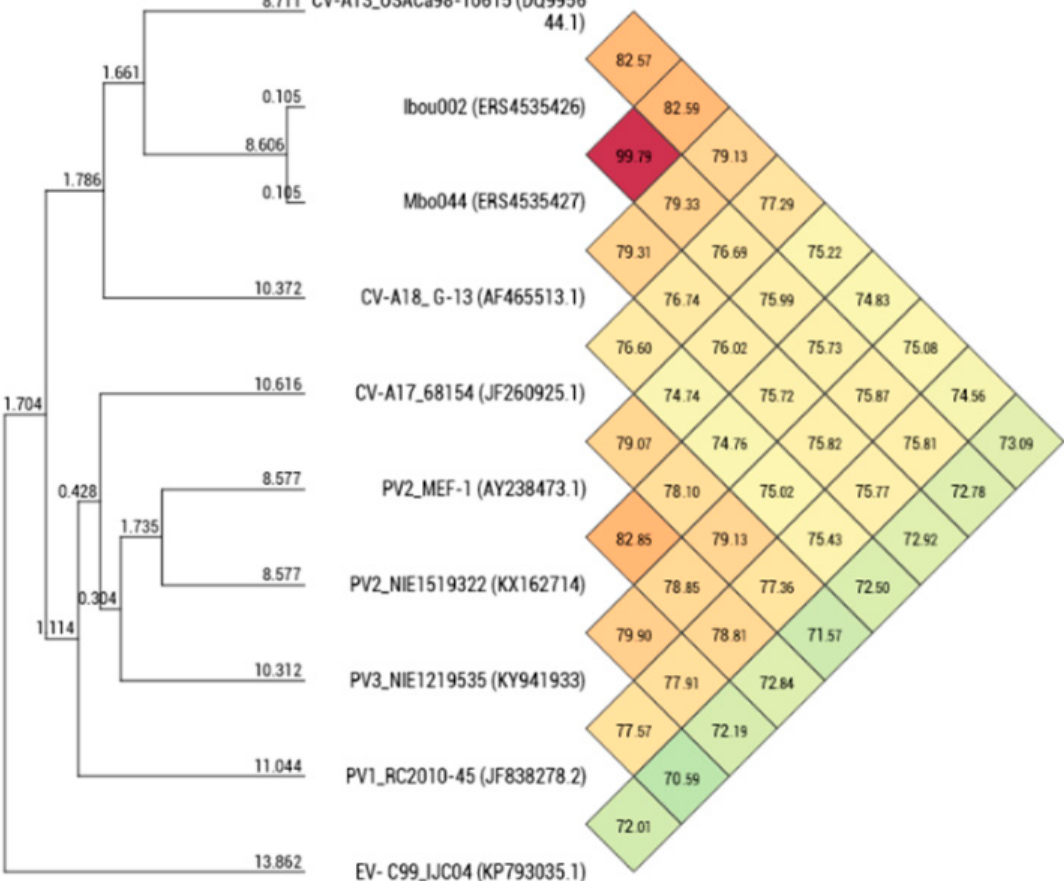
Figure 5. Phylogenetic tree based on the complete VP1 ( A ) and VP2 ( B ) sequences of the human enterovirus serotypes and EV strains in this study. Isolates in the present study are indicated in green (VP1) and red (VP2) circles while EV-C isolates previously described in the Congo and elsewhere are in blue.